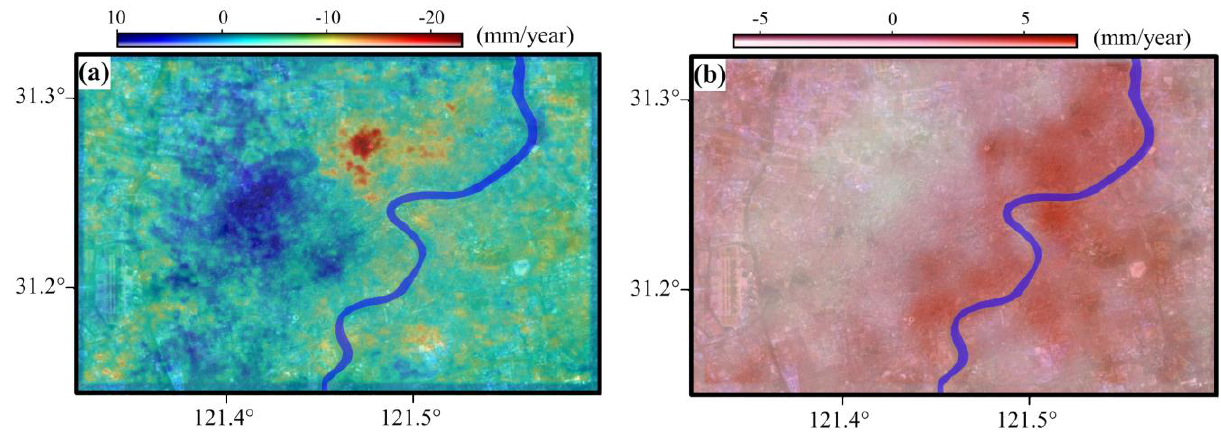
Figure 6. The maps of the resultant VDRs ( a ) and the relative E–W displacement rates ( b ) in the study area derived by the localized LS method based on the multi-platform SAR